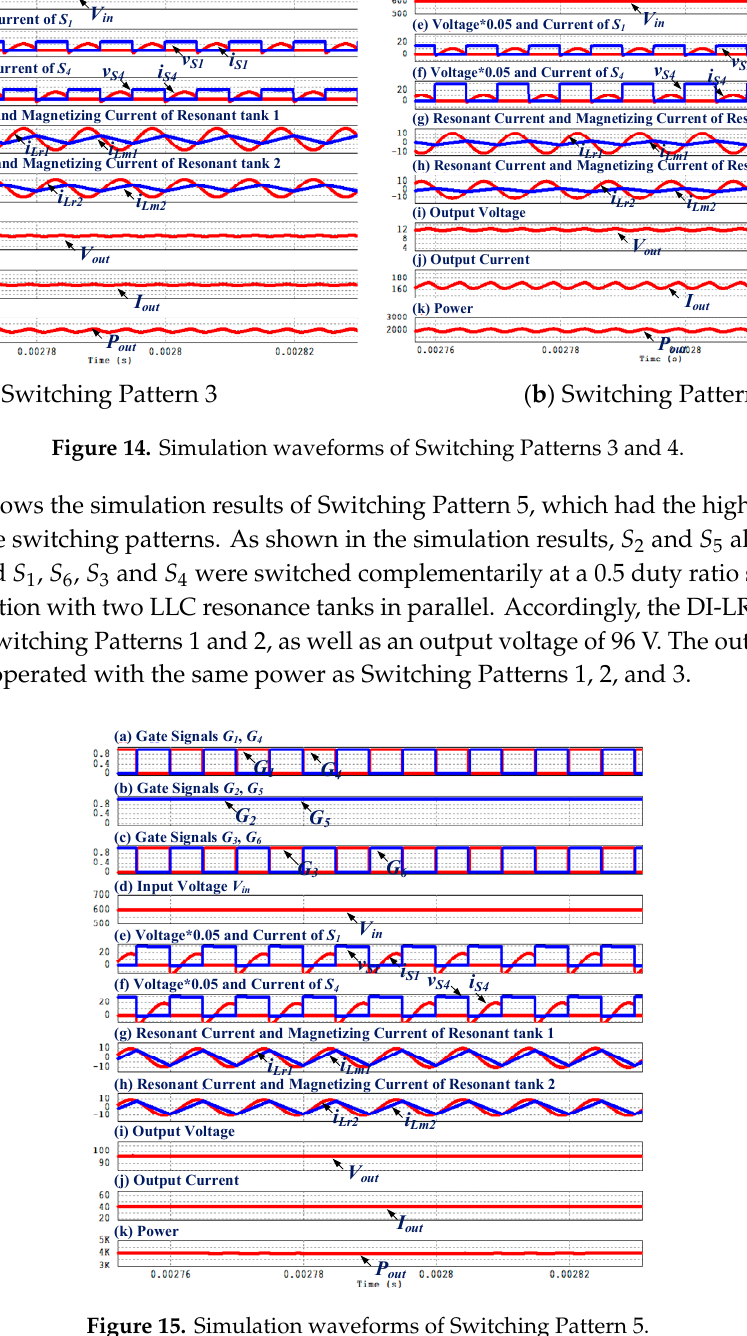
Figure 15. Simulation waveforms of Switching Pattern 5.